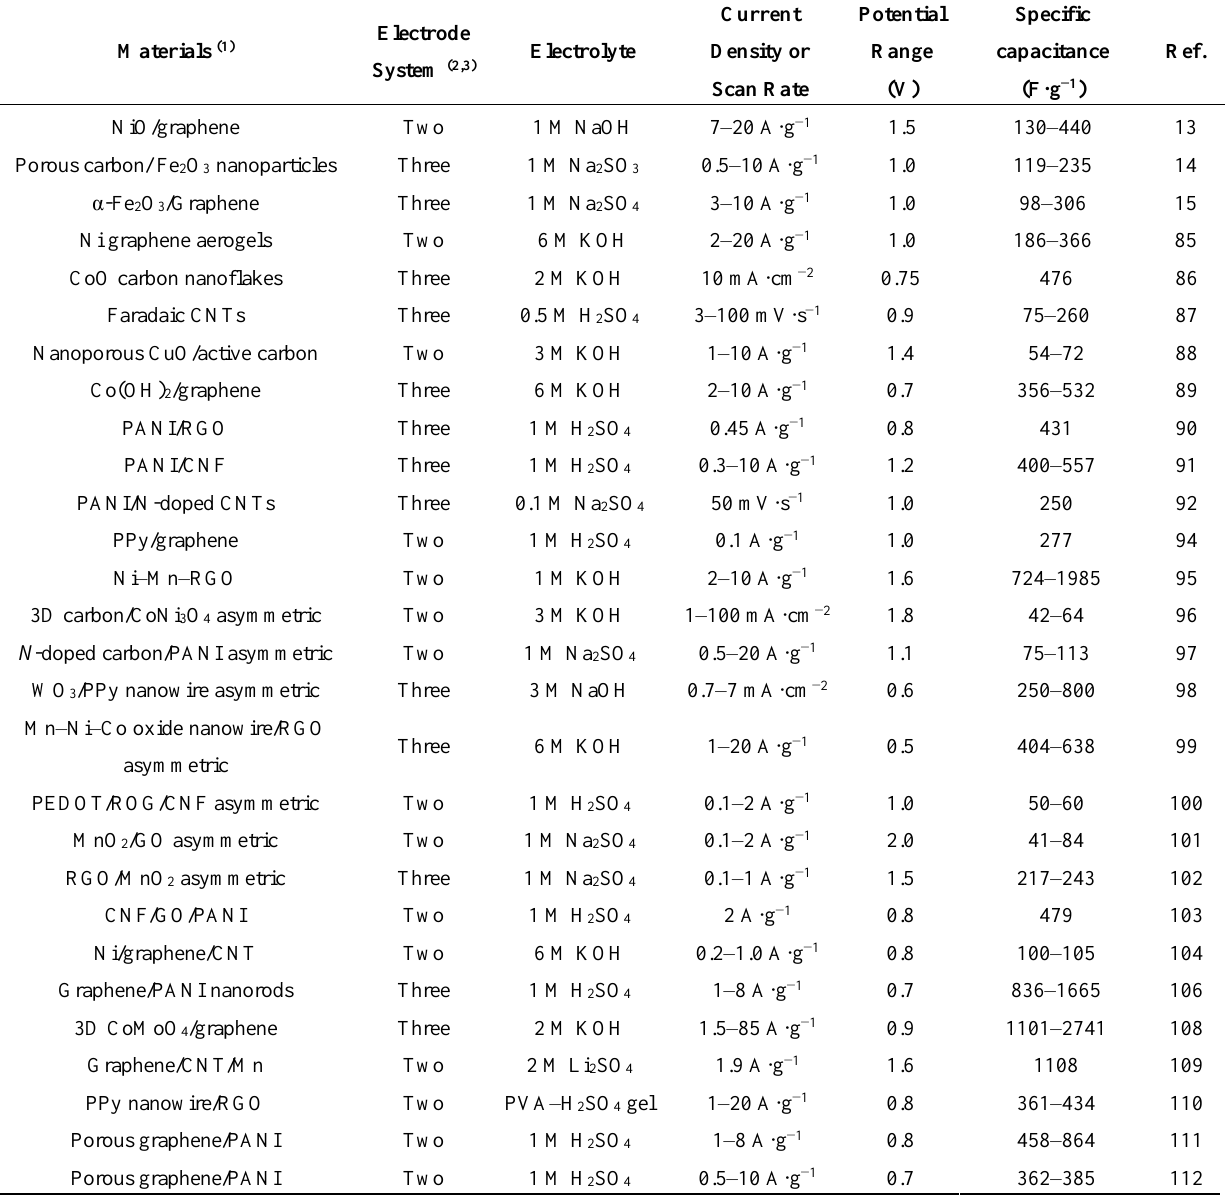
Table 3. Hybrid capacitor materials and electrochemical